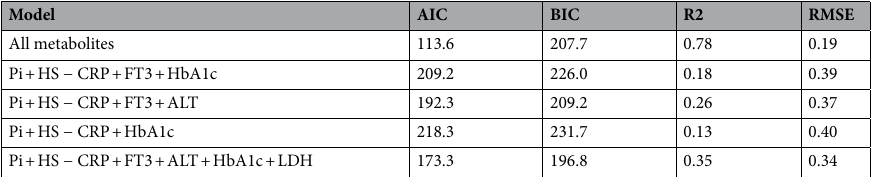
Table 2. Performance comparison of candidate logistic regression models. Performance of logistic regression models for the outcome “responder”. AIC Akaike’s information criterion, BIC Bayes information criterion, R 2 Tjur’s R 2 , RMSE root mean square error.